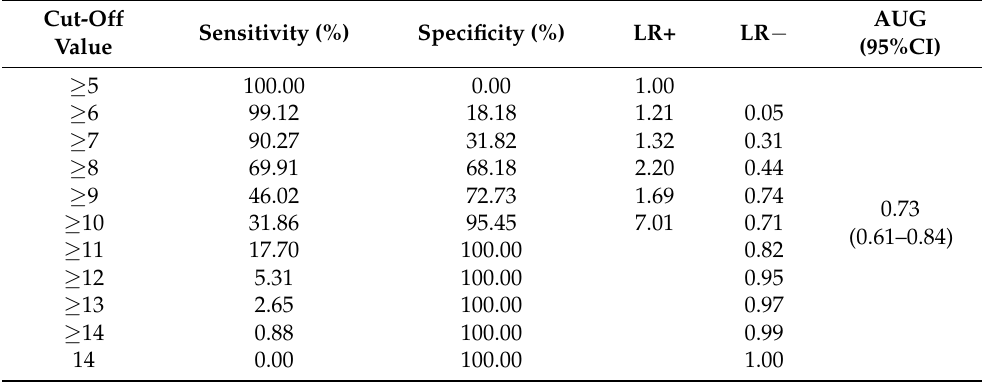
Table 3. The screening tool-specific STLI cut-off